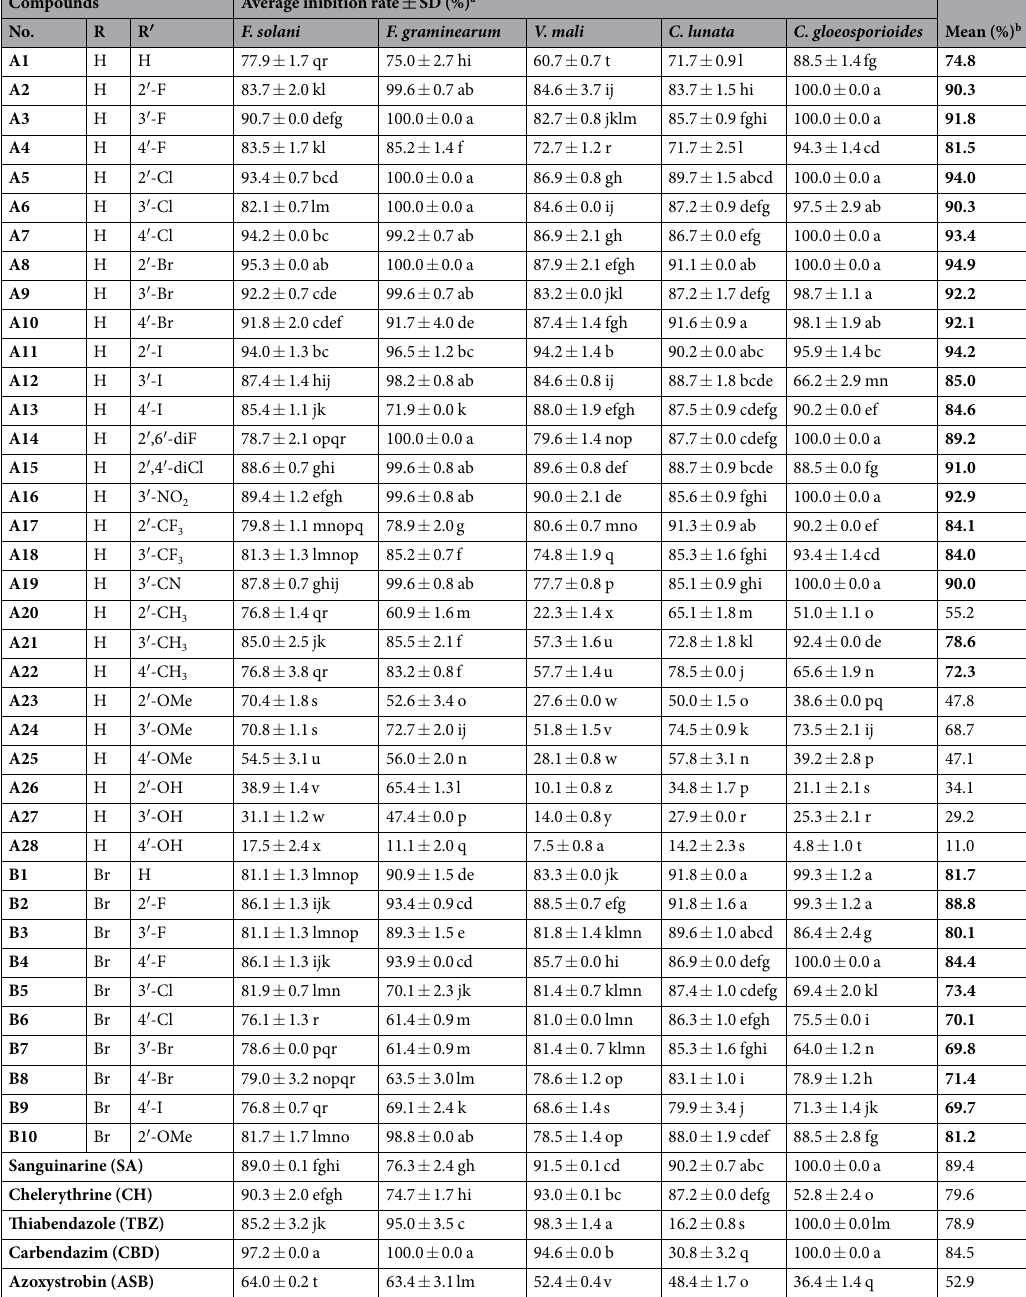
Table 1. Antifungal activity of compounds A and B at 150 μ M. a The difference between the data with the different letters within a column is significant for the same fungi ( P < 0.05). b Mean: the average values of inhibition rates of the same compound on the five test